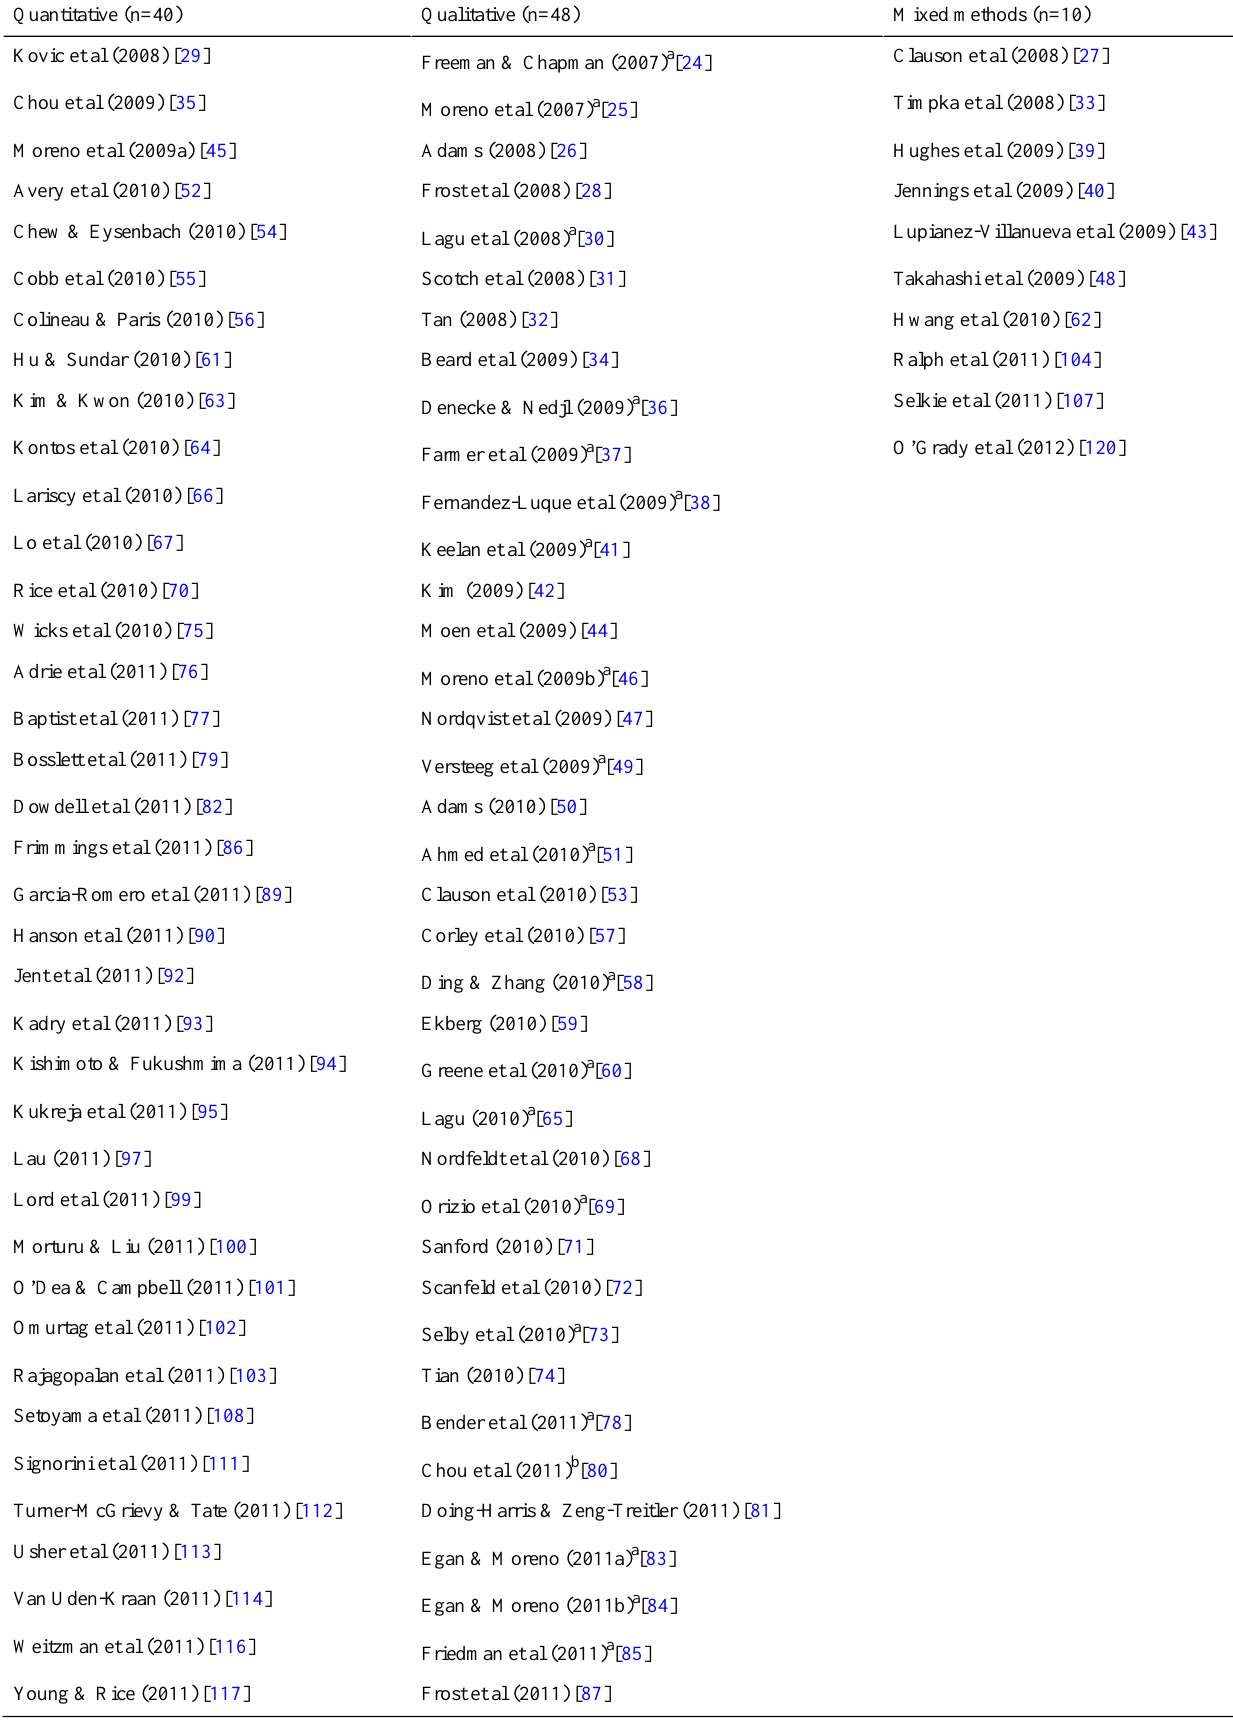
Table 2. List of studies by methodology—quantitative, qualitative, or both